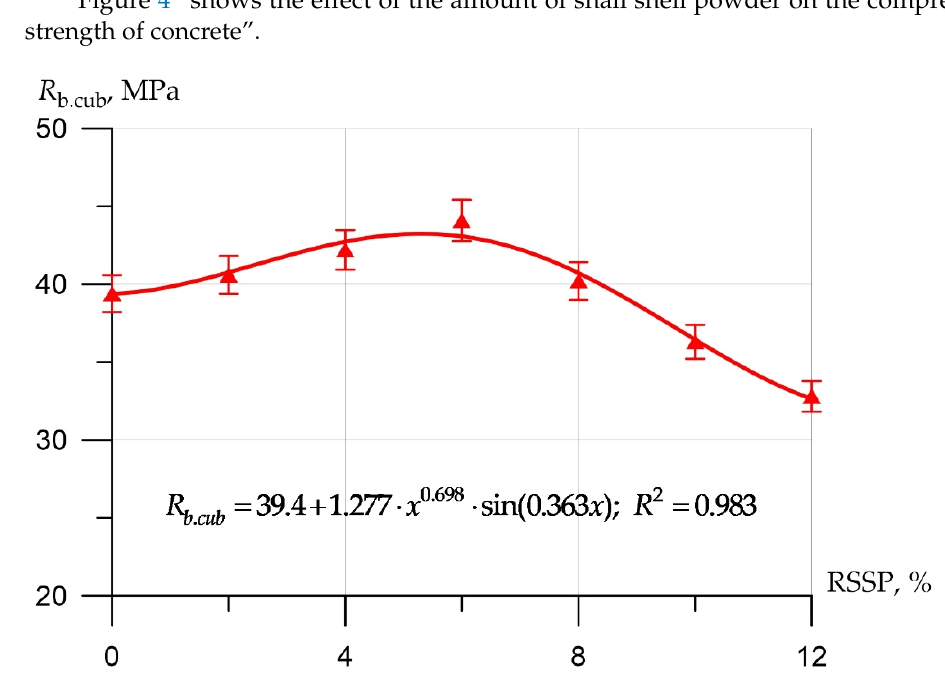
Figure 4. Compressive strength of snail shell powder concrete.